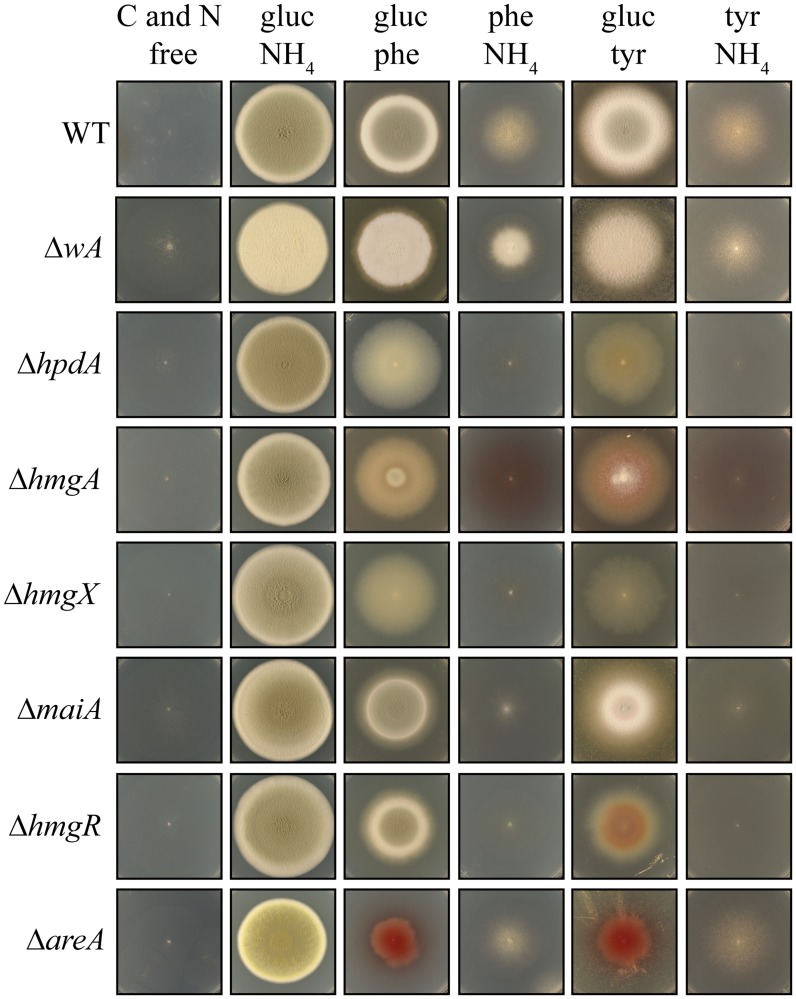
Genes of the tyrosine catabolic cluster are required for hyphal growth on tyrosine and phenylalanine as a nitrogen or carbon source at 25°C.Growth of the wildtype, ΔwA, ΔhpdA, ΔhmgA, ΔhmgX, ΔmaiA, ΔhmgR, and ΔareA strains on carbon and nitrogen free medium (C and N free), on ammonium as the sole nitrogen source (gluc NH4), on phenylalanine as the sole nitrogen source (gluc phe), on phenylalanine as the sole carbon source (phe NH4), on tyrosine as the sole nitrogen source (gluc tyr) or on tyrosine as the sole carbon source (tyr NH4) after 14 days at 25°C.